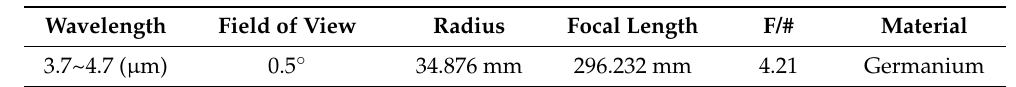
Table 1. Parameters of the optical